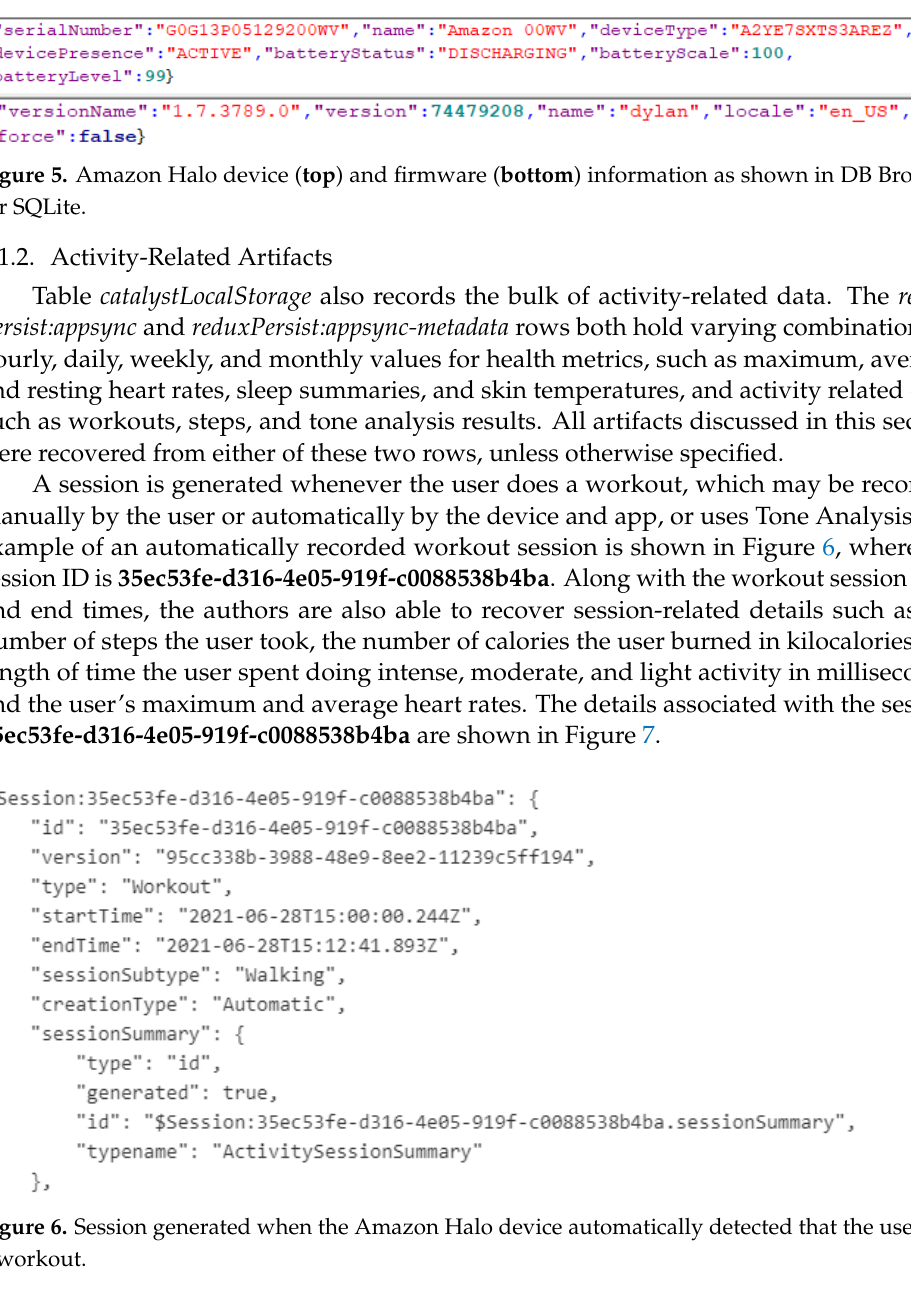
Figure 4. Amazon Halo user’s profile and PII as shown in DB Browser for SQLite.